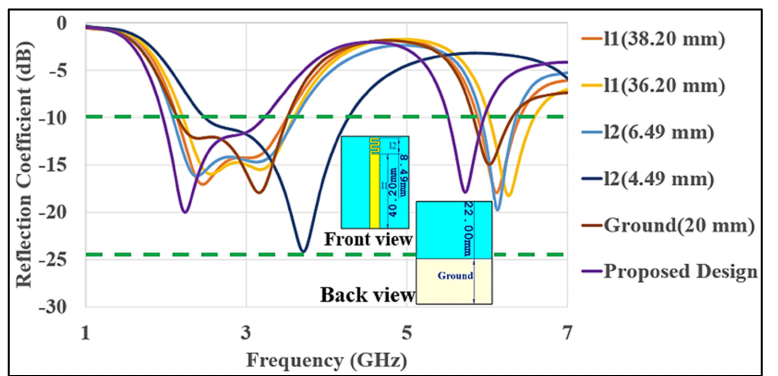
Figure 4. Variation in the S 11 by changing the length (l 1 and l 2 ) of the proposed antenna design.